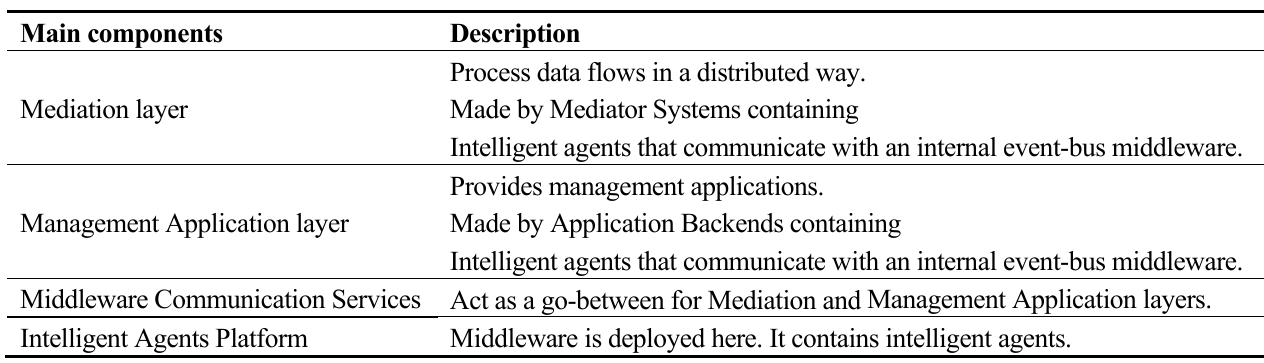
Table 7. Description of IAP-INMS main